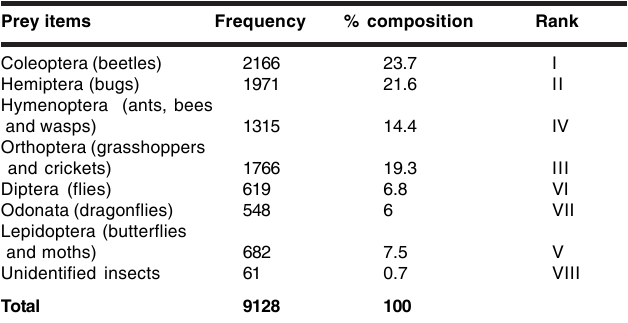
Table 5. Frequency and percent composition of various prey items in the diet of the Black Drongo (n=676 pellets)